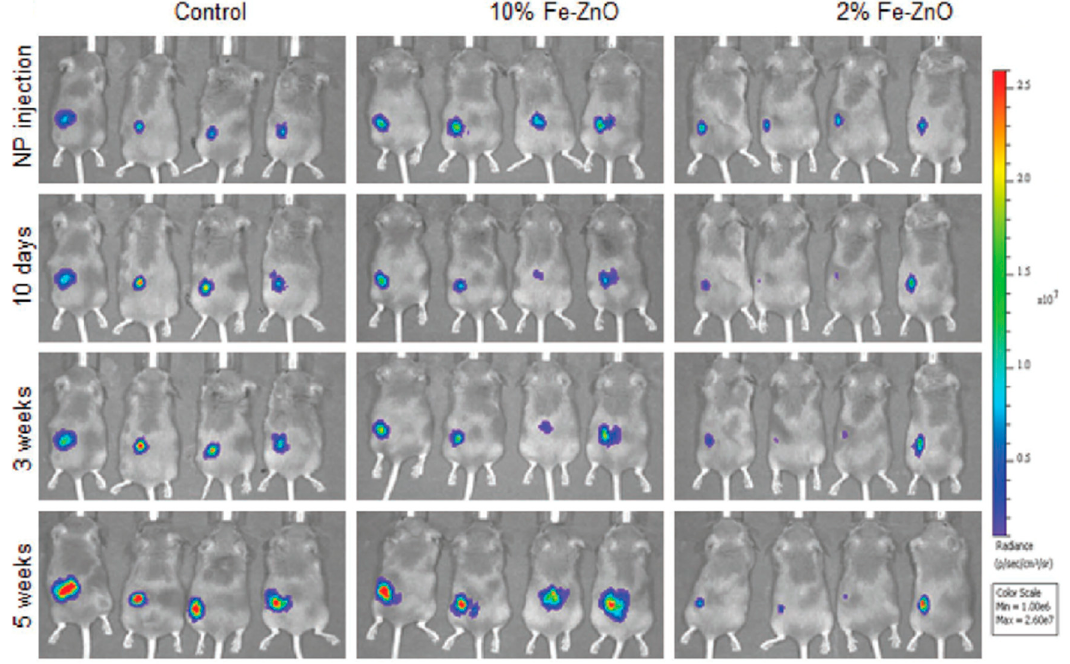
Figure 10. Tumor growth trend in mice at different times and differently doped ZnO nanoparticles. Tumor growth is reduced with 2% Fe-doped ZnO nanoparticles. Adapted from ref. [204] .